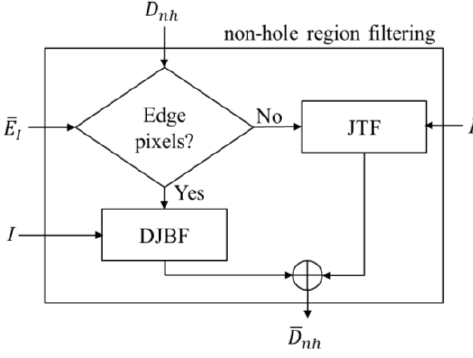
Figure 5. The flowchart of the non-hole region